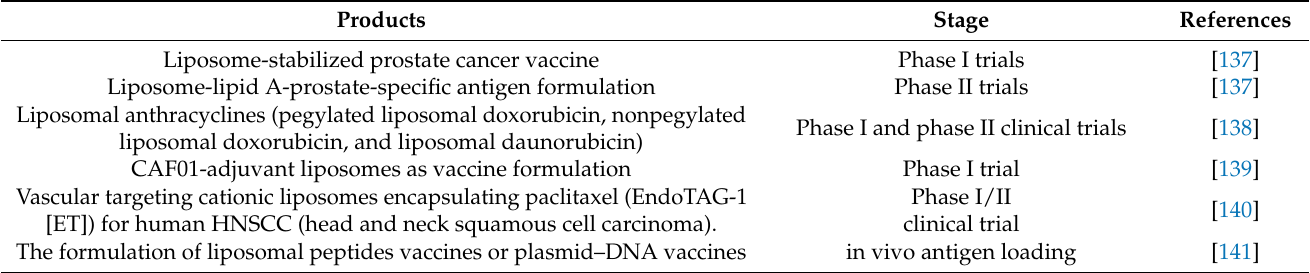
Table 4. Liposomal formulation categorized on clinical trial phase and